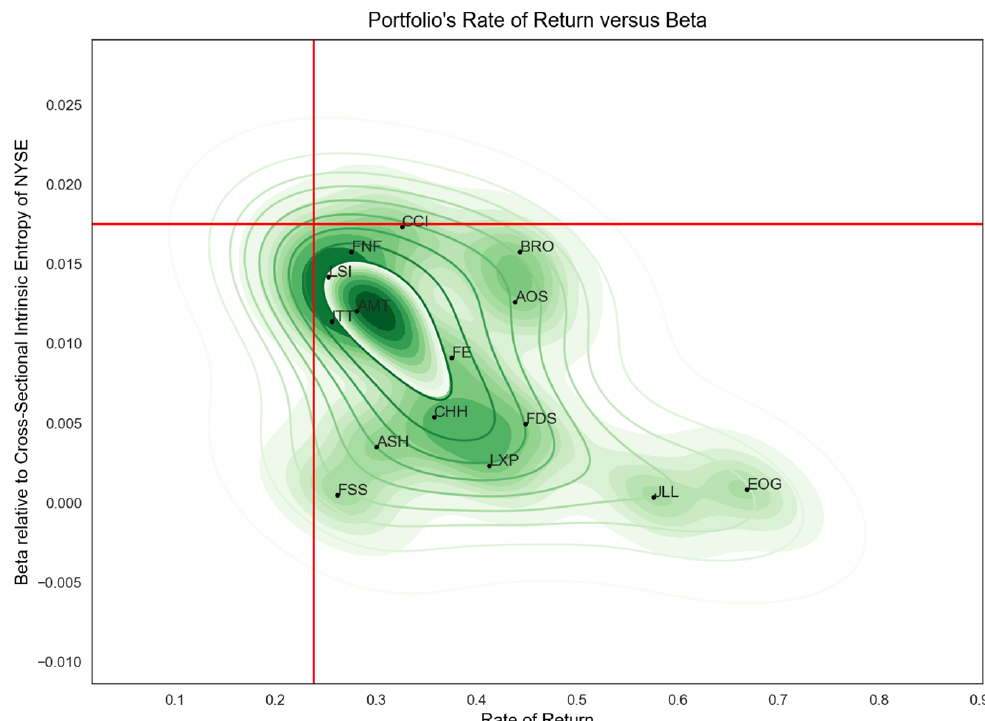
Figure 2. A set of 15 NYSE symbols that outperformed the S&P500 index in terms of rate of return without being exposed to higher risk (250-day trading interval, from 5 October 2020 to 20 December 2021).